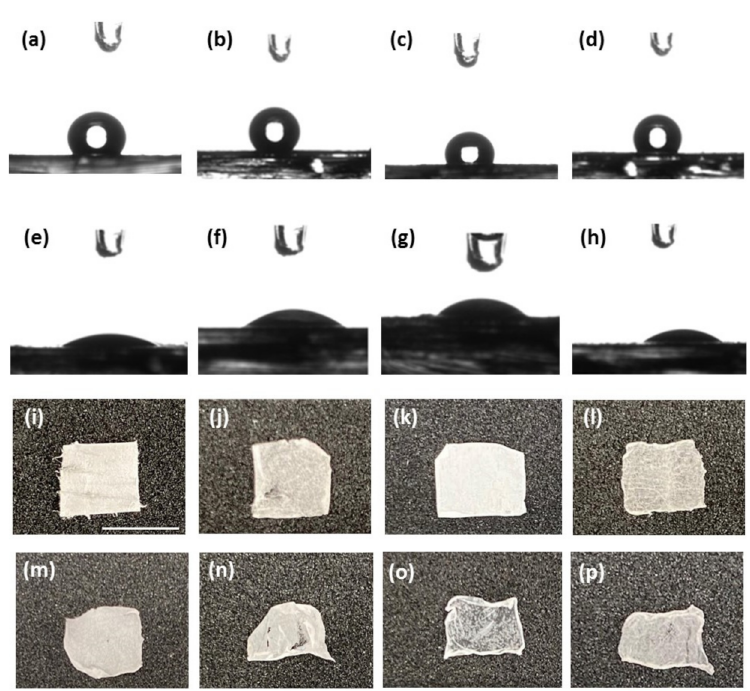
Figure 4. Characterization and surface properties of HA, FmocFRGD, and PCL electrospun fibers. ( a – d ) Images of a water droplet on ( a ) PCL, ( b ) FmocFRGD + PCL, ( c ) HA/PCL core/shell, and ( d ) HA + FmocFRGD/PCL core/shell scaffolds. ( e – h ) Images of a water droplet after plasma treatment on ( e ) PCL, ( f ) FmocFRGD + PCL, ( g ) HA/PCL core/shell, and ( h ) HA + FmocFRGD/PCL core/shell scaffolds. ( i – l ) Images of the electrospun scaffolds ( i ) PCL, ( j ) FmocFRGD + PCL, ( k ) HA/PCL core/shell, and ( l ) HA + FmocFRGD/PCL core/shell. ( m – p ) Images of the electrospun scaffolds after 24 h immersion in cell culture media: ( m ) PCL, ( n ) FmocFRGD + PCL, ( o ) HA/PCL core/shell, and ( p ) HA + FmocFRGD/PCL core/shell. Scale bar = 7